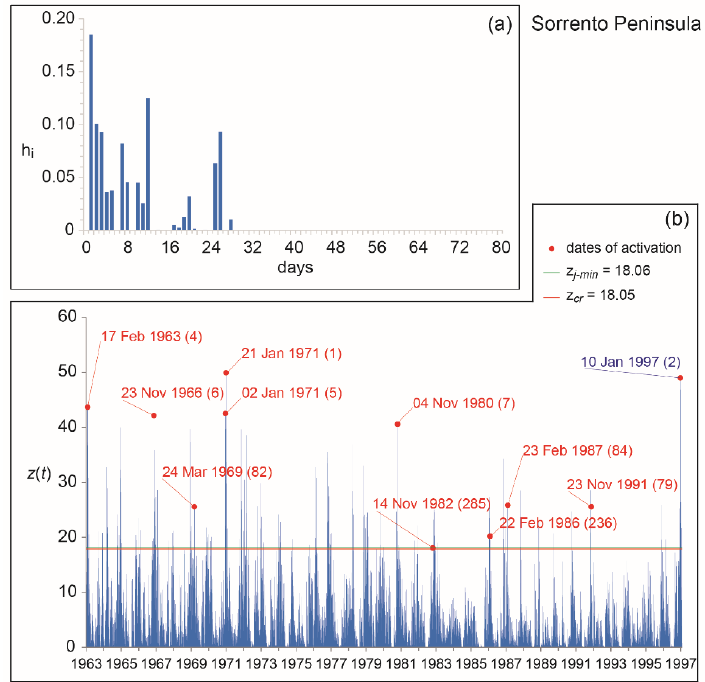
Figure 10. Sorrento Peninsula case study: ( a ) optimal kernel; ( b ) mobility function obtained by applying the optimal kernel to the entire set of available activation dates (cf. [17]).